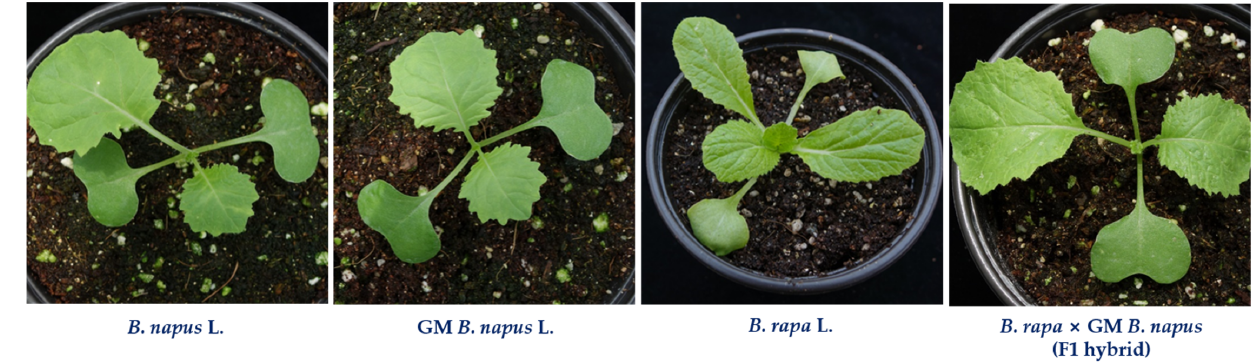
Figure 6. Representative photos of plants selected for the spectral